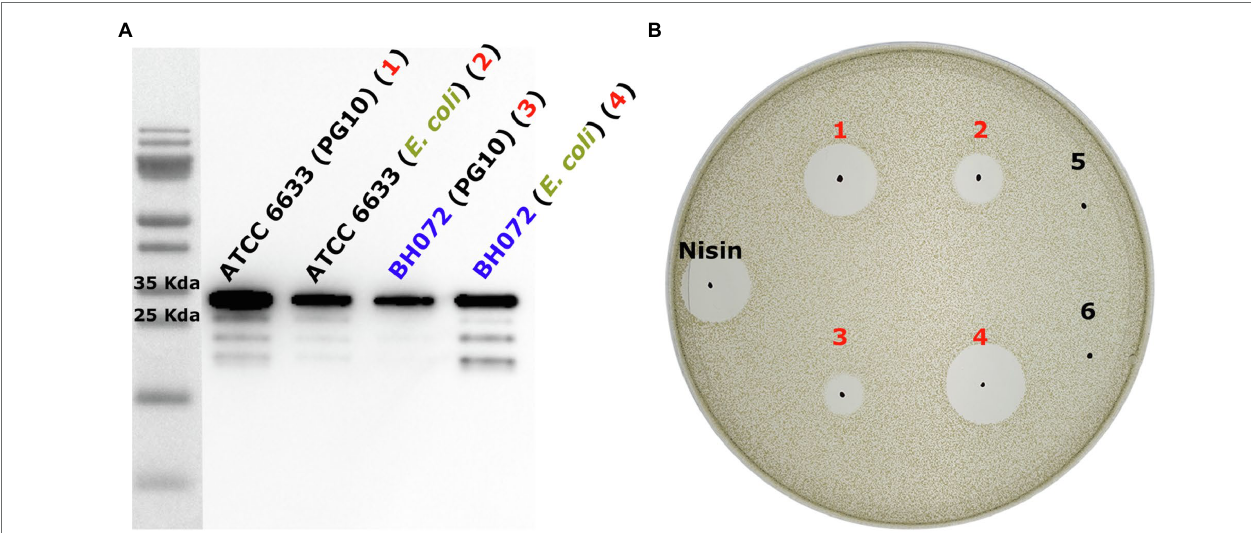
FIGURE 3 | (A) Anti-Histag western blot of heterologously expressed AprE-His from ATCC 6633 and BH072 in either B. subtilis PG10 or Escherichia. coli BL21(DE3). All AprE-His variants are located on the gel at their approximate autoprocessed size, 28655.3 Da (ATCC 6633) and 28370.1 Da (BH072; Supplementary Material S2 ). While ATCC 6633 AprE-His is expressed very well in PG10, the expression level of BH072 AprE-His in this strain is much lower. The expression level of both AprE-his variants in E. coli BL21(DE3) is equally high and of an average level when compared to the expression levels in PG10 (B) The four produced AprE-His samples were used to cleave fully modified His6-MrsA in an antimicrobial activity test against M. flavus . Comparing both the PG10 produced ATCC 6633 AprE-His (1) and the BL21(DE3) produced ATCC 6633 AprE-His (2) to BL21(DE3) produced BH072 AprE (4), it is clear that BH072 AprE cleaves the mersacidin leader at a much higher efficiency than ATCC 6633 AprE. It is possible that BH072 AprE-His production in PG10 can be increased by changing the signal peptide sequence to that of ATCC 6633 AprE. Negative control samples 5 and 6 are, respectively, digested with an empty plasmid control expression and His-tag elution